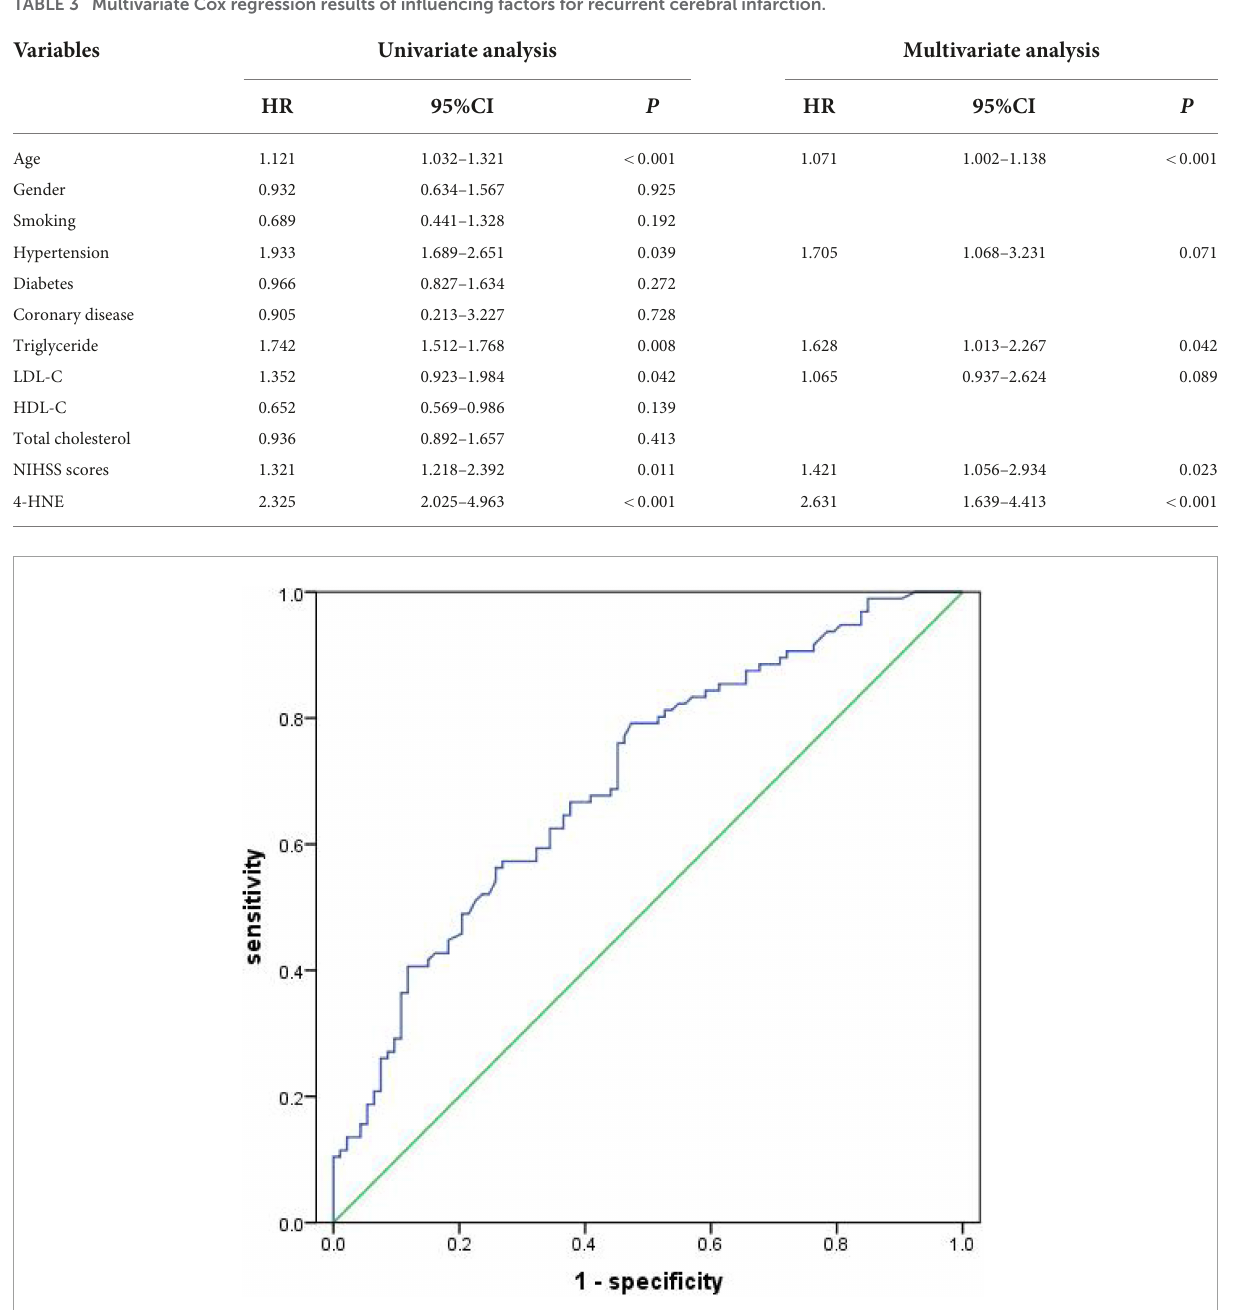
the main mechanisms related to the recurrence of